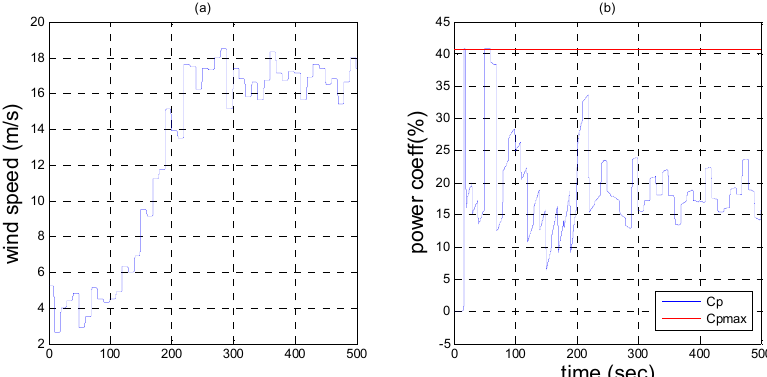
Figure 24. Wind input and overall efficiency in Region 3: ( a ) Wind input; ( b ) Overall power coefficient.